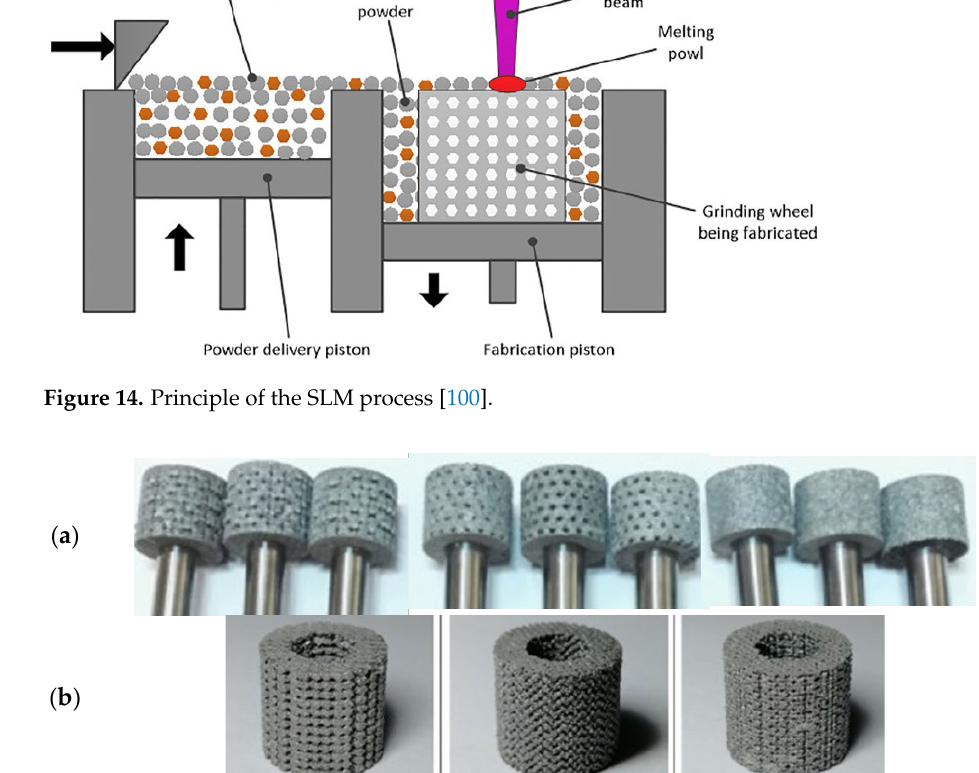
Figure 15. Abrasive wheels structured by the SLM method by ( a ) Tian et al. [100] and ( b ) Li et al. [103].